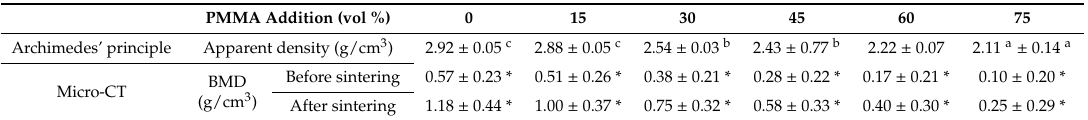
Table 3. Apparent density and bulk specific gravity of the HA sca ff olds with respect to the PMMA addition